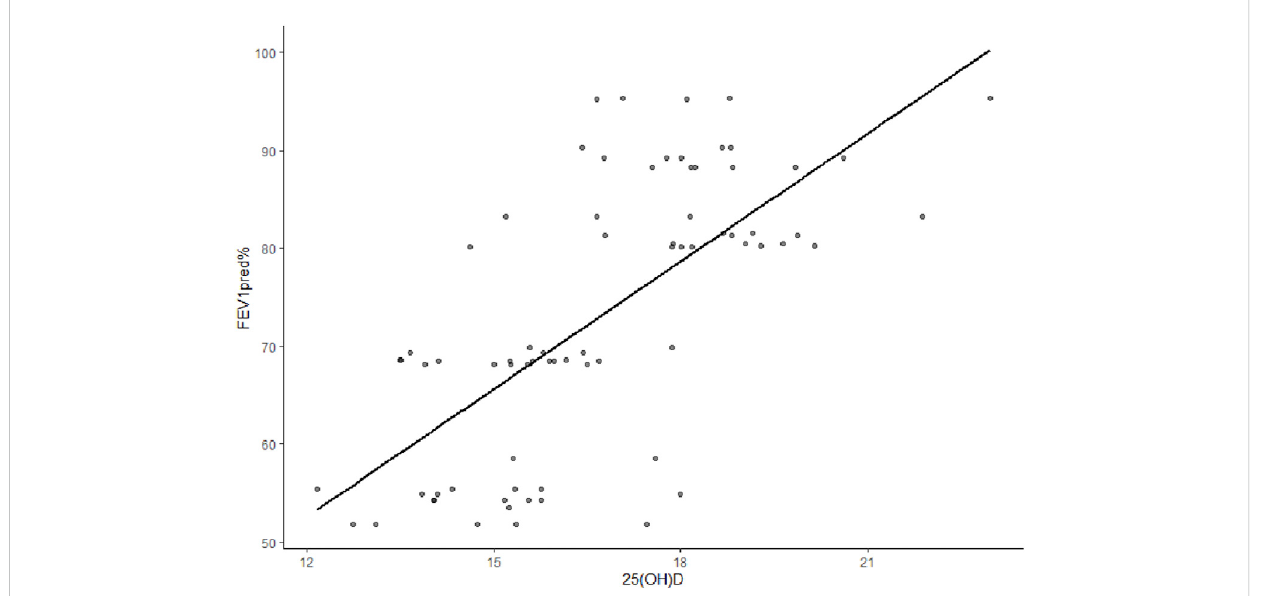
Correlation analysis between 25(OH)D level and FEV1pred% in early COPD. The 25(OH)D level and FEV1/FVC were positively correlated, with a r (correlation coef fi cient) of 0.695 ( p <